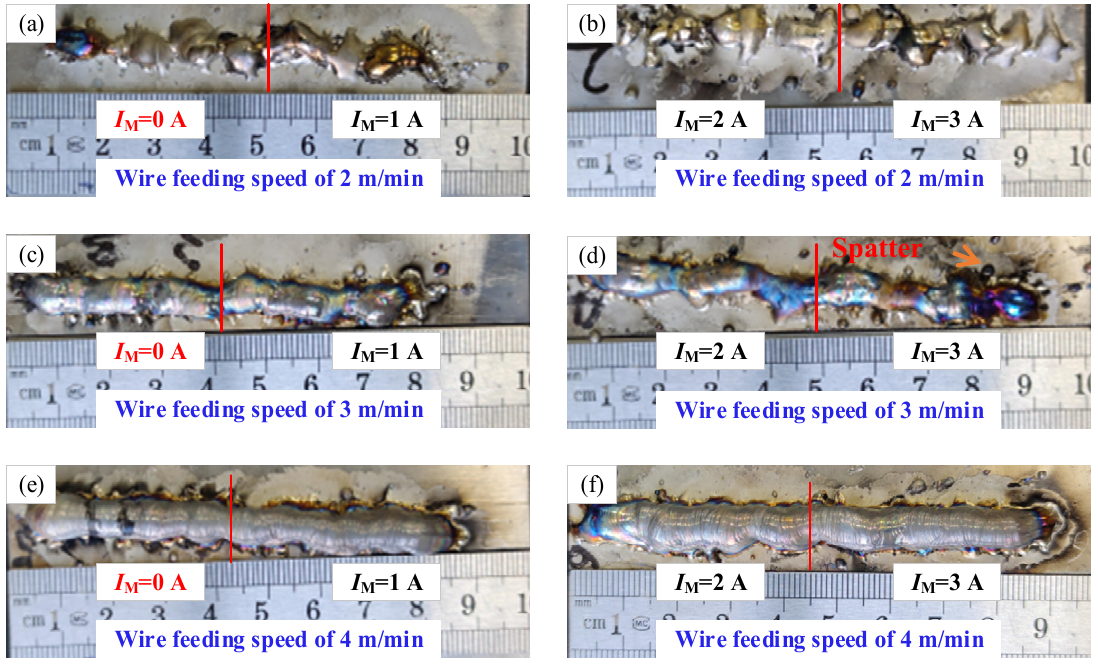
Figure 6. Surface morphology of deposition layer with the short-circuiting transfer.